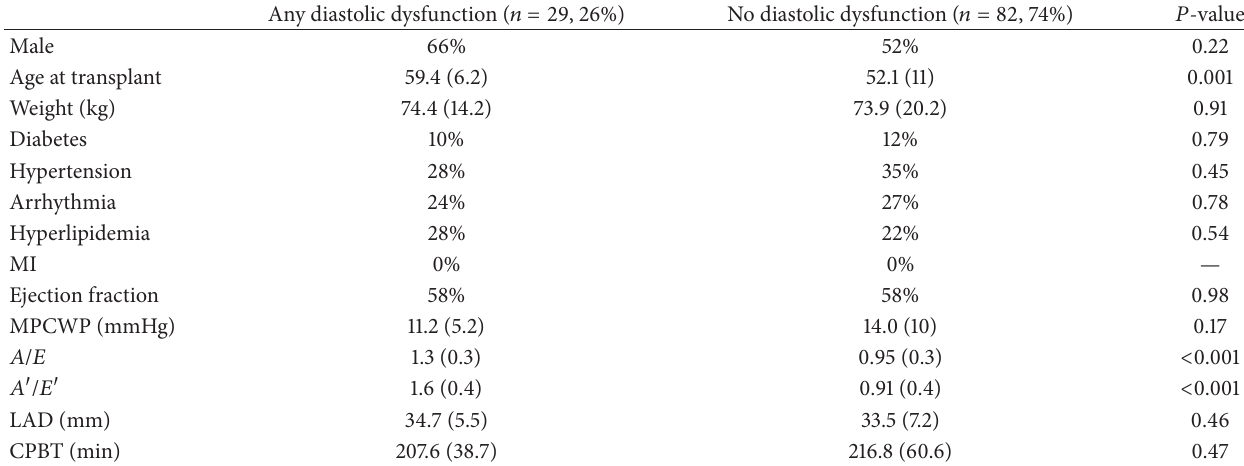
Table 1: Demographics between diastolic and nondiastolic dysfunction groups. Numbers presented as mean (standard